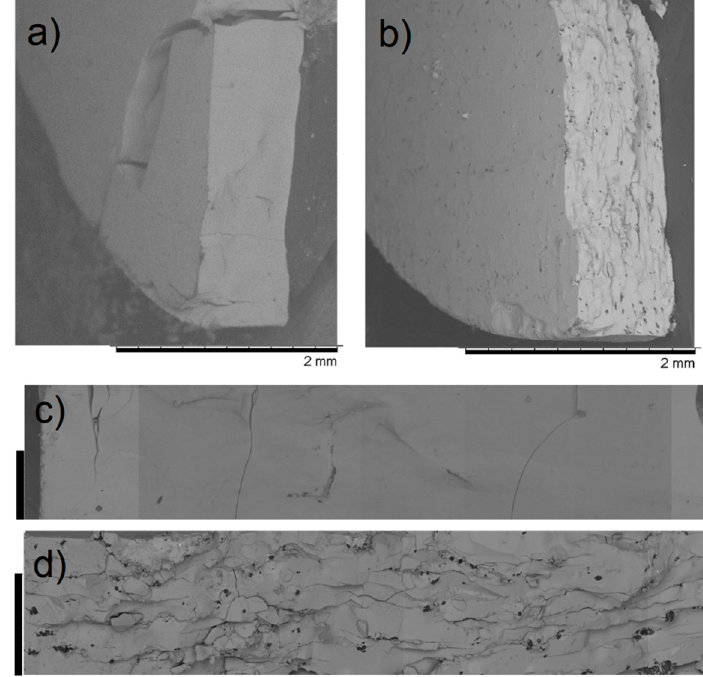
Figure 7. SEM micrographs of pellets prepared compressing at 438 MPa for 2 min using neat MOF-801 ( a , c ) and a mixture containing 5 wt % PVB ( b , d ). For ( c , d ), the scale bars on the left-hand side are 300 µm.